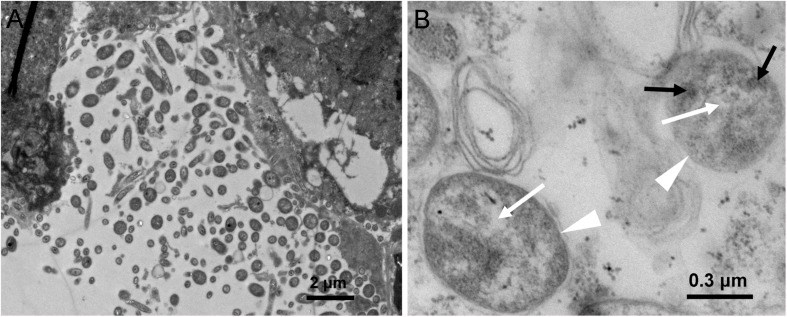
TEM micrographs of an WBPH adult female hindgut. (A) Hindgut lumen of female WBPH. (B) Detail of panel A, showing two bacteria (indicated by white triangle), where black arrowheads indicate enterosomes in the bacterial cytoplasm, and white arrowheads indicate bright filamentous nucleoid region.